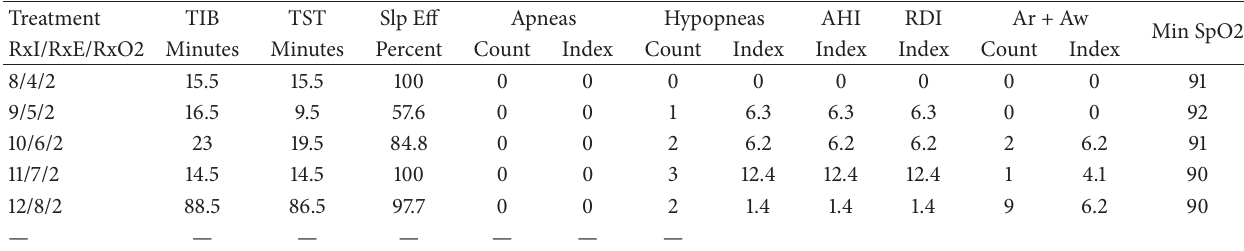
Table 4: Treatment parameters and results/with dual